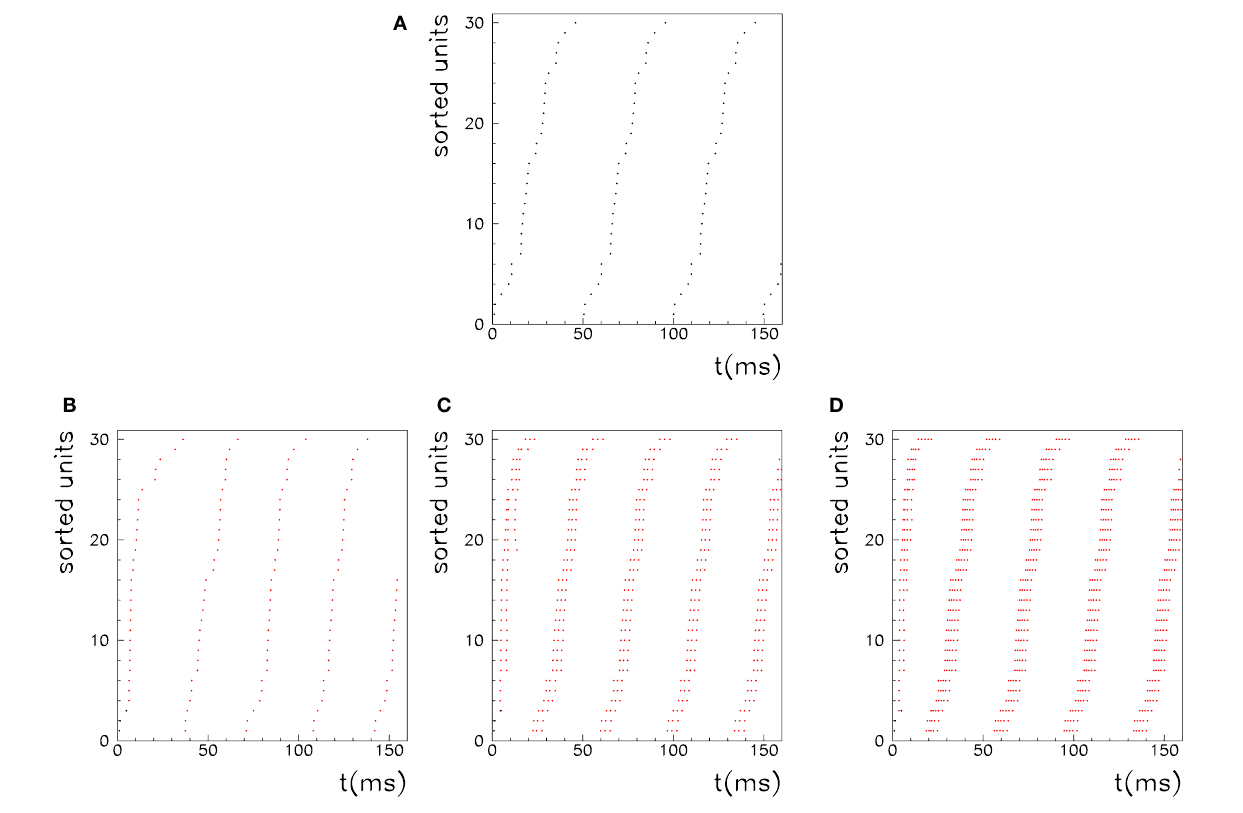
Figure 5 | recall of a pattern by the spiking iF model, with N = 1000 learning rule. (A) Thirty neurons of the network are randomly chosen and sorted neurons and ϕ * = 0.24 π . One pattern ( P = 1) defined by the phases φ µ i is stored by the value of the phase φ µ i . Then the phases of the encoded pattern are in the network with the rule given by Eq. (4). Then a short train of M = 150 shown, plotting on the x axis the times ( )/ φ π ω µ n + 2 , and on the y axis the µ i spikes, at times t with ω /2 π = 20 Hz, is induced on the neurons that label of the neuron. (B) The replayed pattern with threshold T = 85 is shown, μ have the M lowest phases φ µ i . This short train triggers the replay of the pattern plotting on the x axis the times of the spikes, and on the y axis the label of the by the network. Depending on the value of T , the phase-coded pattern is spiking neuron. Black dots represent externally induced spikes, while red dots replayed with a different number of spikes per cycle. Note that changing T in represent spikes generated by the intrinsic dynamics of the network. (C) The our model may correspond to a change in the value of physical threshold or in replayed pattern with threshold T = 50. (D) The replayed pattern with the value of the parameter η Ã ( ω ) appearing in the synaptic connections J threshold T = μ ij